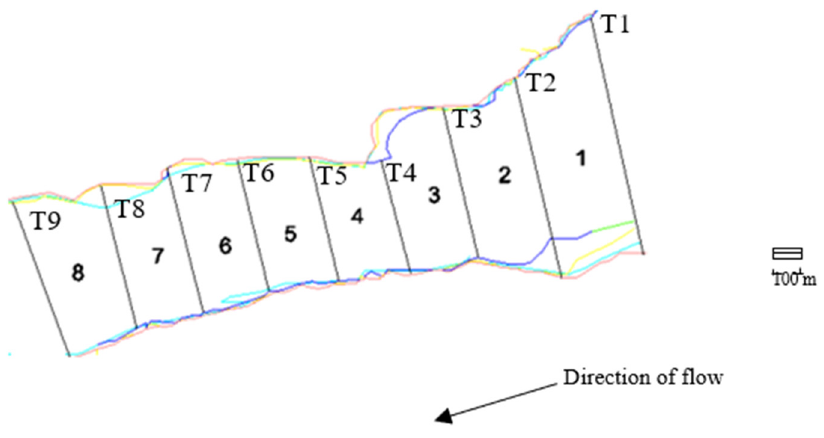
Figure 4. External boundary of all considered images and external limit, polygons and transients.